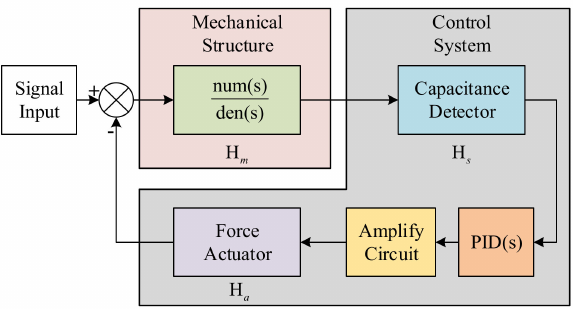
Figure 5. The schematic model of control system of ESA. H m denotes the transfer function of mechanical structure, H s denotes the transfer function of capacitive displacement detector and H a denotes the transfer function of electrostatic force